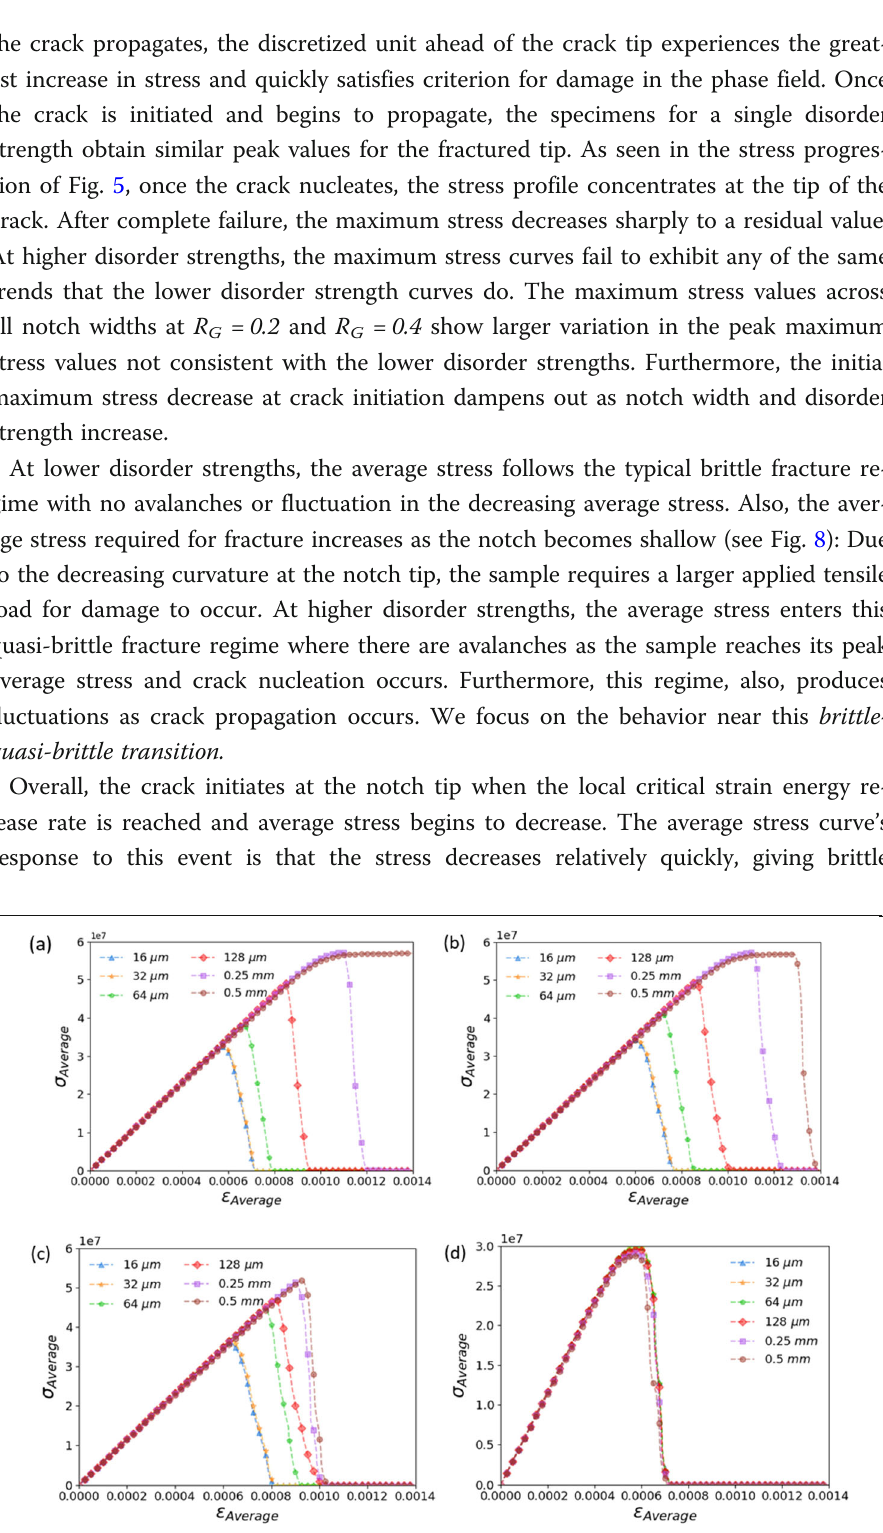
Fig. 8 Effect of disorder on average stress: The average stress of the specimens of Lx = 8 μ m, Ly = 0.5 mm, and Lz = 1.0. mm where D = 2.995 as a function of the average strain with respect to RG where ( a ) has a RG = 0.0, ( b ) has a RG = 0.1, ( c ). has a RG = 0.2, and ( d ) has a RG = 0.4. The figure legends signify the notch width W that varies from 0.25 to 128 μ